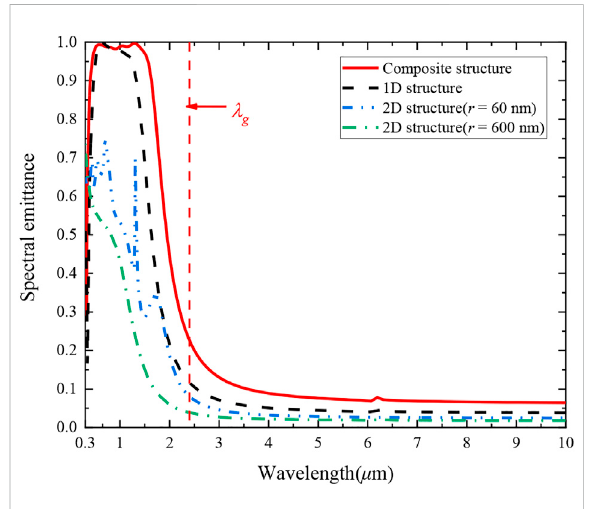
FIGURE 3 Comparison of spectral emittance of one-dimensional structures ( LP = 10, d M = 10 nm, d D = 80 nm), two-dimensional array cavity structures ( r = 60 nm, a = 200 nm, h = 900nm, n c = 1and r = 600 nm, a = 1,300 nm, h = 900nm, n c = 1) and compositestructures( LP =10, d M =10 nm, d D =80 nm ,r =60 nm, a = 200 nm, h = 900 nm, n c =